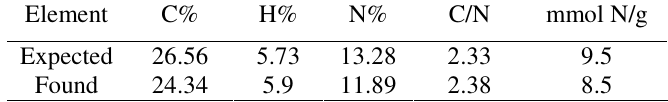
Table 1 . Elemental analysis for polysiloxane-immobilized triamine ligand system (P-DTA).